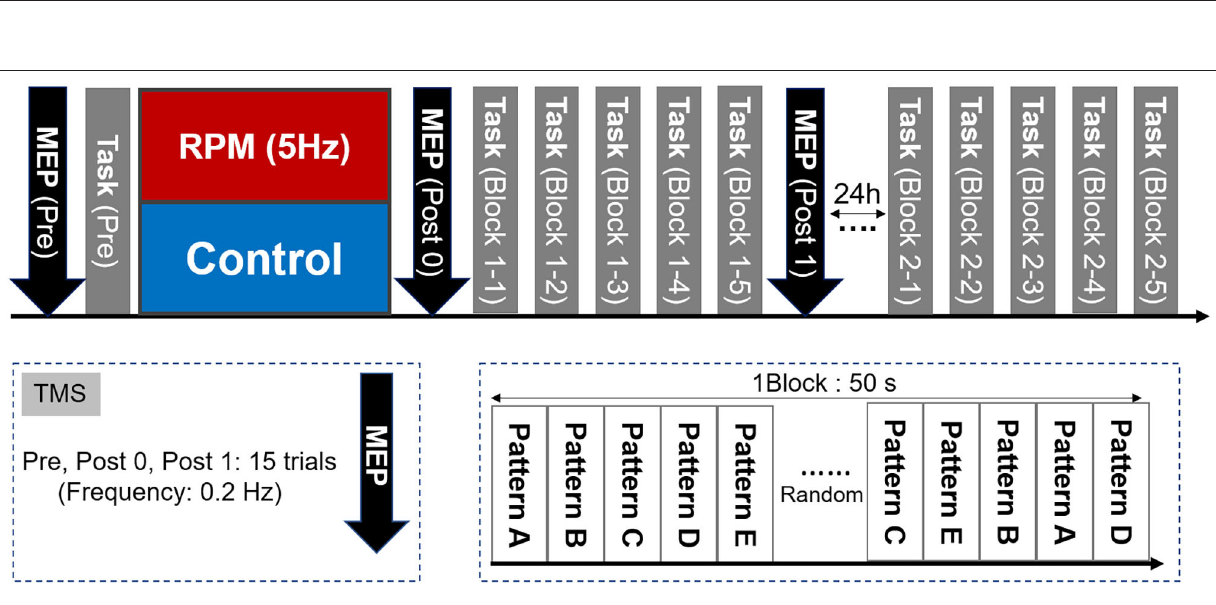
FIGURE 3 | Experimental Protocol. First, we measured the MEP as a baseline value and evaluated the motor performance in the visual tracking task. The MEP was then measured again after the intervention of either the RPM condition or the Control condition. Subsequently, five visual tracking tasks were performed as a motor learning task. A total of 50 waveforms were presented randomly per block. One block lasted 50s. A 10s break was provided between each block, to avoid fatigue. After the motor learning task, the MEP was measured again. On the following day (24h later), five blocks of the visual tracking task were performed in the same way as that used on the 1st day, to assess motor performance